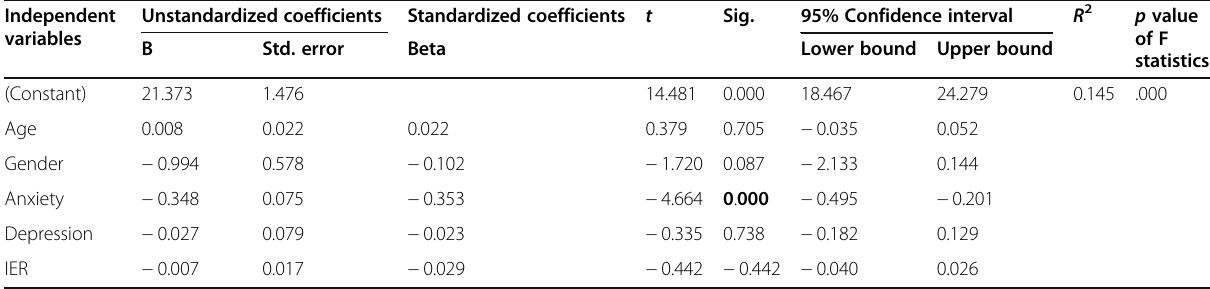
Table 6 Regression analysis of the effect of personal and psychological factors on ACT ( N = 264) Independent